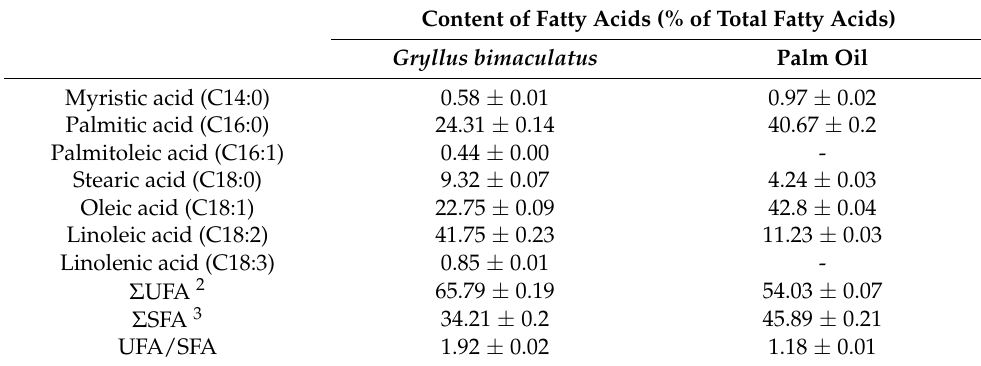
Table 1. Composition of fatty acids in fresh Gryllus bimaculatus and palm oil (% of total fatty acids) 1 . Content of Fatty Acids (% of Total Fatty